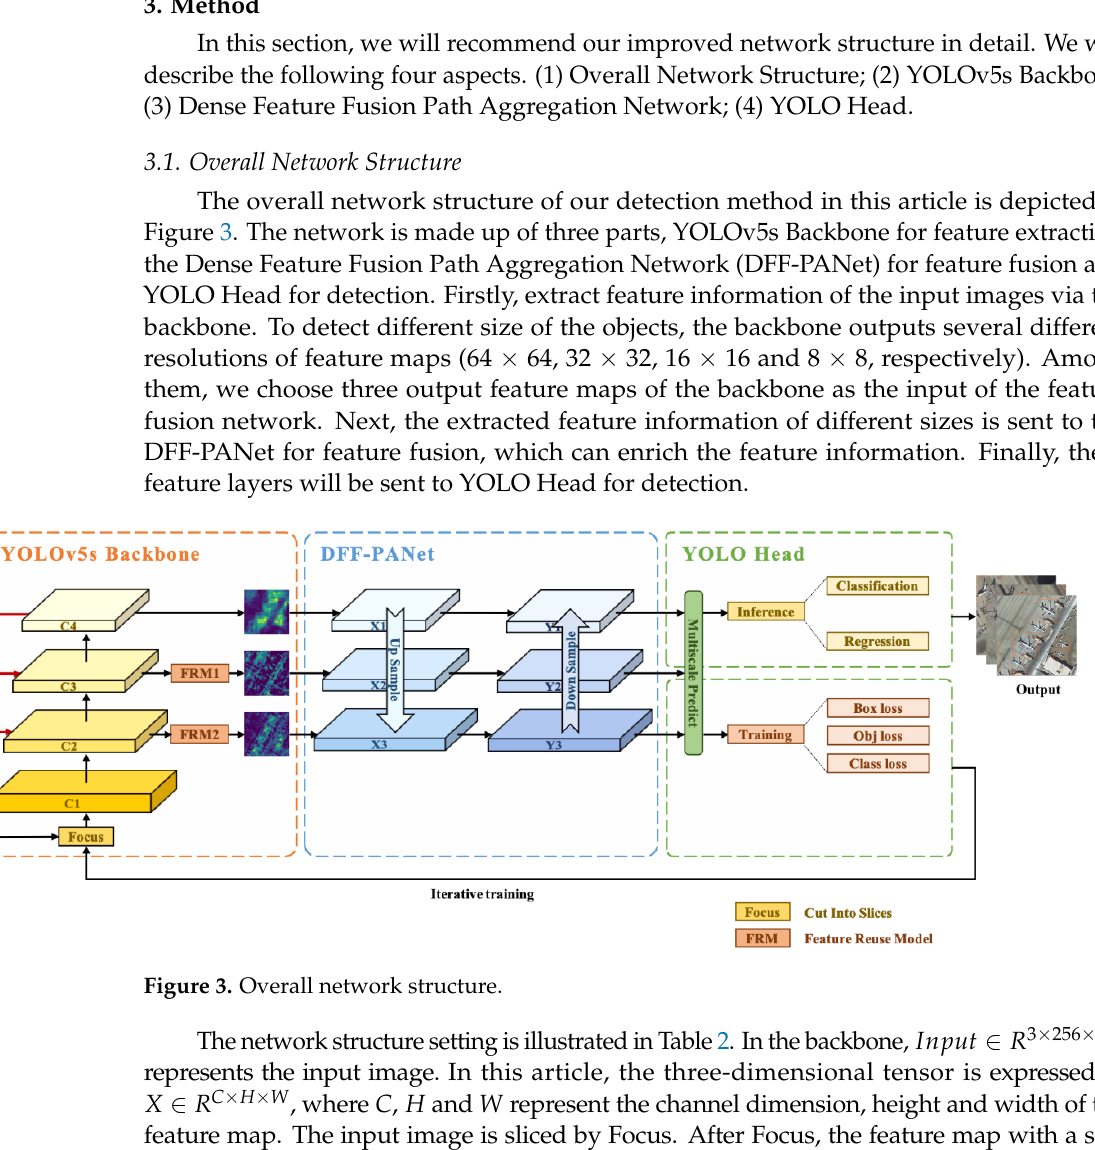
Figure 2. Different feature pyramid network structures. ( a ) Predict using feature maps of different sizes; ( b ) combining information from top and bottom feature maps; ( c ) adding top-down and bot- tom-up paths; ( d ) multi-level feature reuse pyramid.